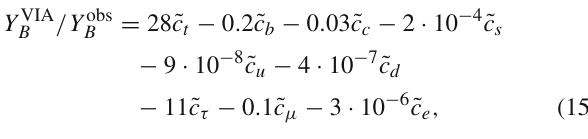
to the profile (cid:11)χ 2 of the global fit, and the 1 σ , 2 σ and 3 σ confidence regions are shown as white, light-gray and dark-gray dashed contours, respectively. The best-fit point and the SM case are marked by a white star and an orange cross,